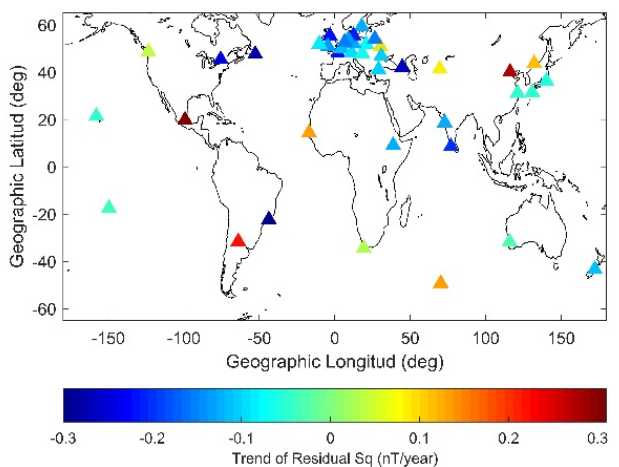
Figure 4. Global distribution of 40 residual Sq trends that passed through a trend test as a function of geographical latitude and longitude. (Adapted from Shinbori et al. [65]: Figure 8).